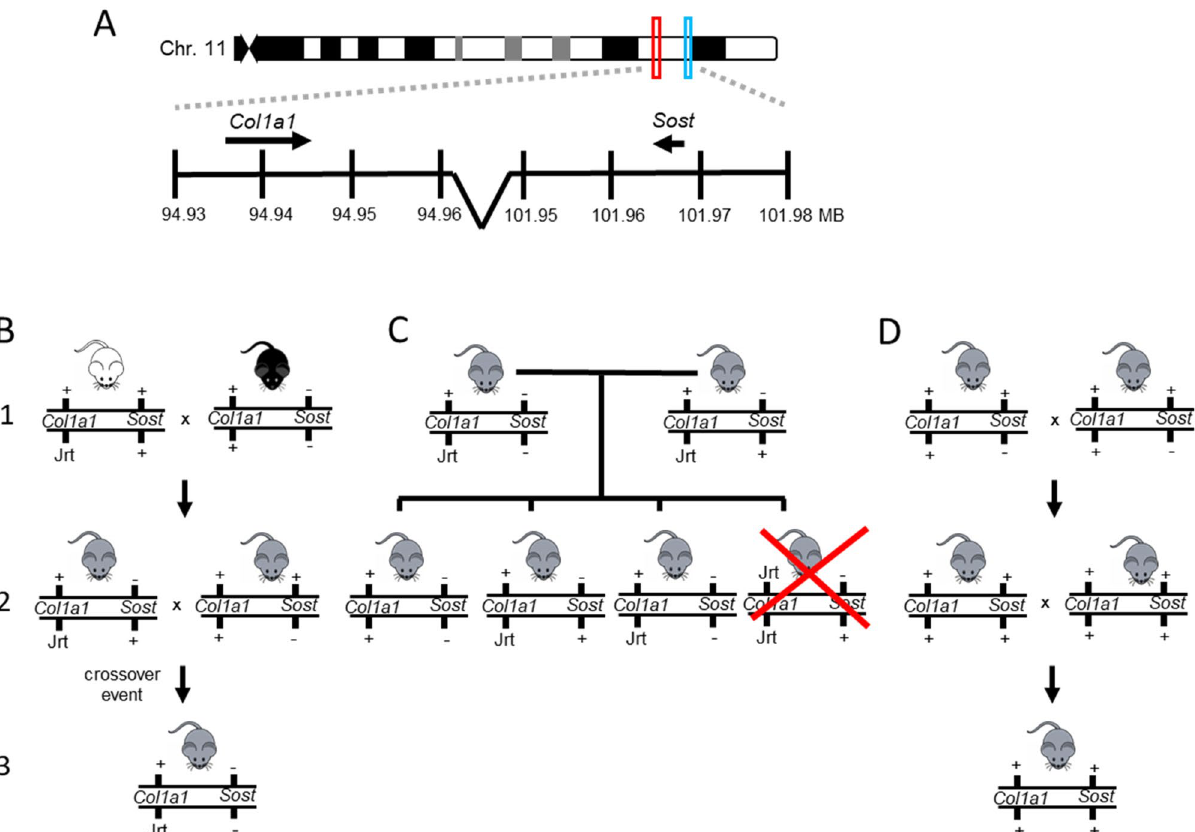
Figure 1. Chromosomal location of Col1a1 and Sost and breeding strategy. ( A ) Col1a1 and Sost are both located on murine chromosome 11, separated by about 7 MB (assembly GRCm38.p6). ( B ) Col1a1 Jrt/ + (FVB background) and Sost −/− (C57BL6 background) mice were bred (1) to generate Col1a1 Jrt/ + ; Sost + /− and Col1a1 + / + ; Sost + /− mice of mixed background (2). These mice were then crossed until a crossover event was observed that resulted in the generation of a Col1a1 Jrt/ + ; Sost −/− mouse (3). ( C ) Col1a1 Jrt/ + ; Sost −/− mice were bred with Col1a1 Jrt/ + ; Sost + /− mice to generate three of the four genotypes that were used for phenotype analyses. Mice that are homozygous for the Jrt allele ( Col1a1 Jrt/Jrt ) are not viable and die in utero (and are therefore crossed out in the schematic). ( D ) A separate colony was maintained to generate mice of mixed FVB/C57BL6 background that were wild type for both the Col1a1 and the Sost locus. These mice were used to compare results of the three viable genotypic groups shown in ( C